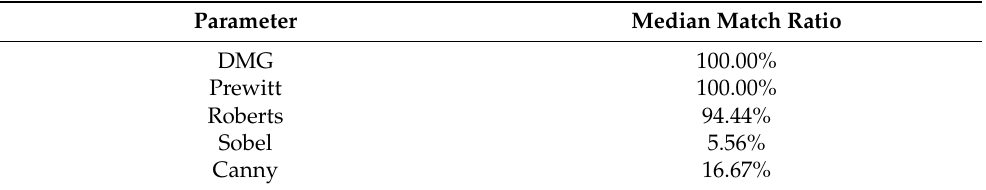
Figure 7. For each of the 17 samples, clustering gap analysis was conducted to approximate the possible object population counts. The results of a single sample are presented here with gap values ( top ), k-means method, with the different colors designating different populations ( middle ), and c-Means with the different colors designating different populations, with the cluster centers ( bottom ). These measurements were used to identify a model for the side scatter measurement of the FCM method that was proportional to the object granularity, with the internal structures identifiable. Table 2. Median match counts for all samples.